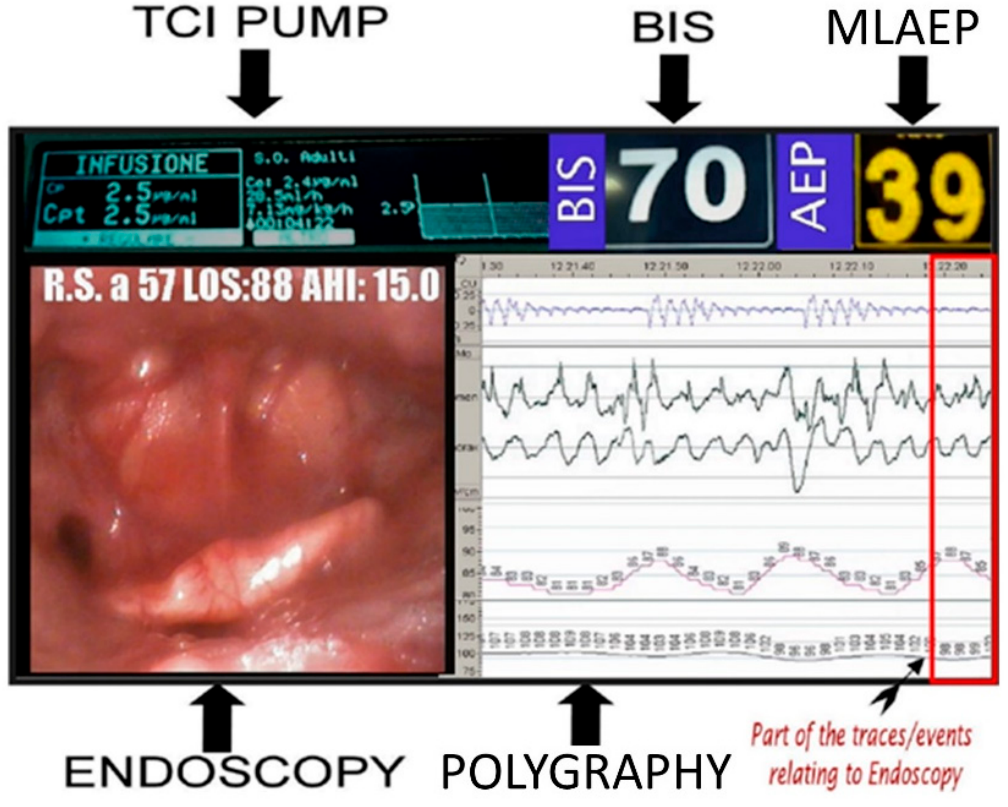
Figure 3. The 5VsEs single screen (“all in one glance” strategy).